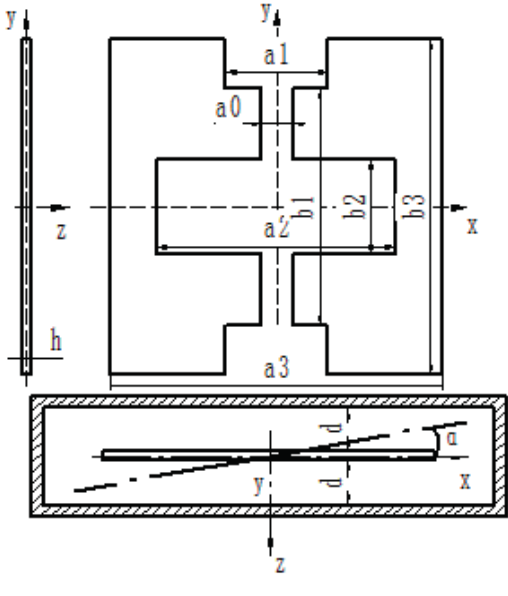
Figure 2. The packaging